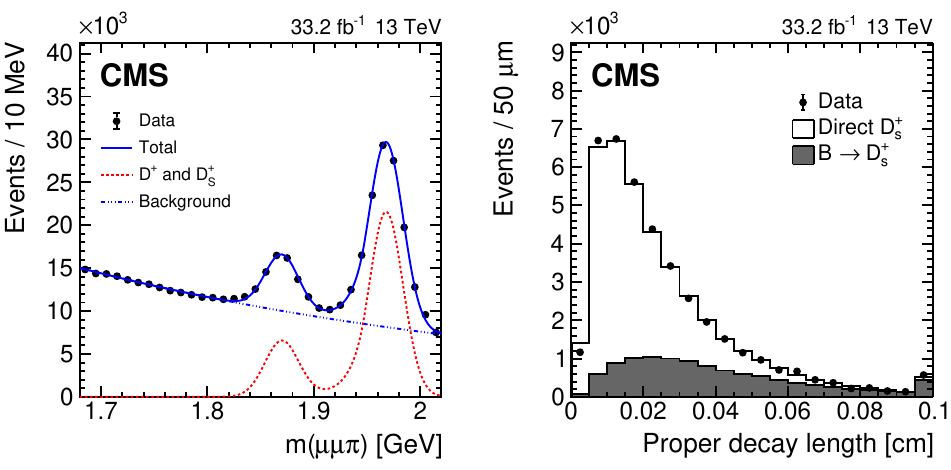
peaks and the s → fp + → s